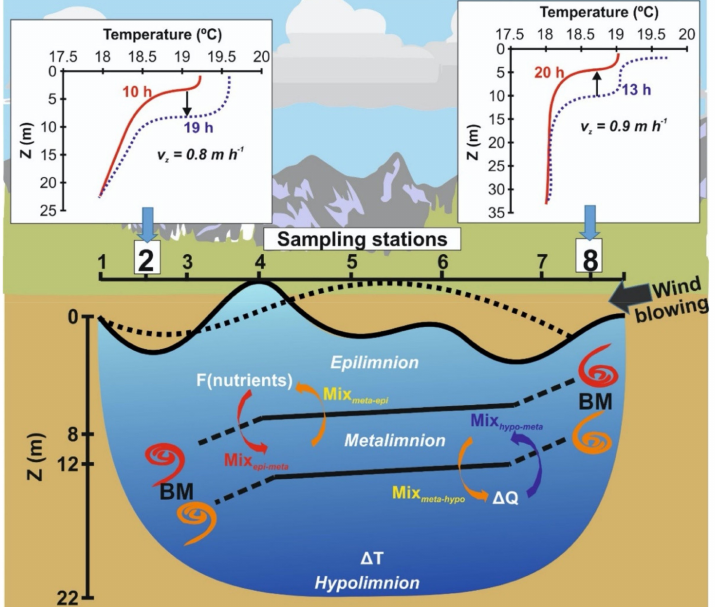
Figure 2. Observed daily thermocline oscillation driven by diurnal wind forcing in VB (top diagrams, taken from [12]), and conceptual mixing model processes considered (see Section 2.4 for further explanation). BM and the spiral symbols represent the boundary mixing events that occur due to the interaction of the thermocline with the bottom and margins of the reservoir